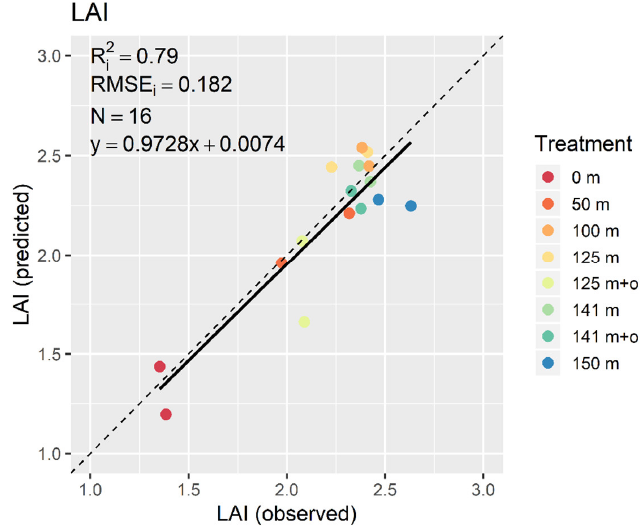
Figure 7. Scatterplot of independently validated partial least-squares regression (PLSR) models for leaf area index (LAI) with the regression line (continuous) and the 1:1 line (dashed).